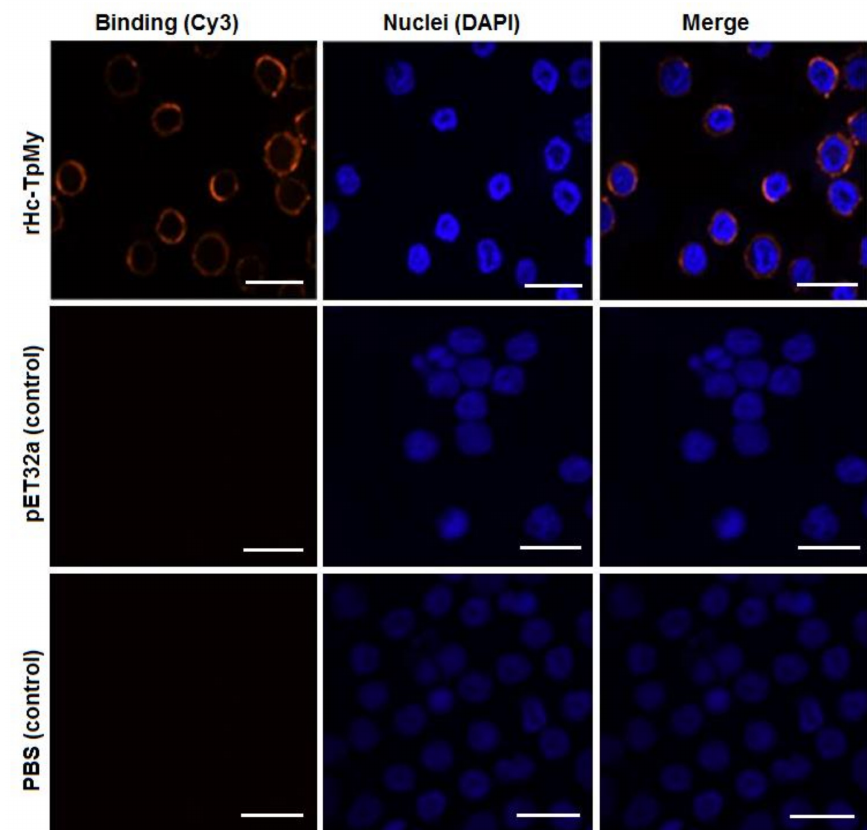
Figure 2. Identification of rHc-TpMy on surface of goat peripheral blood mononuclear cells PBMCs. PBMCs were cultured with rHc-TpMy (10 µ g / mL), pET32a protein (10 µ g / mL) or PBS as control at 37 ◦ C for 2 h, and incubated with anti-rHc-TpMy, anti-pET32a protein or negative rat IgG (as first antibody), followed by staining with Cy3-conjugated secondary antibody (red). Nuclei were stained with DAPI (blue) and visualized at confocal laser scanning microscopy. Merge are the overlaps of red and blue channels. No red fluorescence was observed in control groups. Scale bar 10 µ